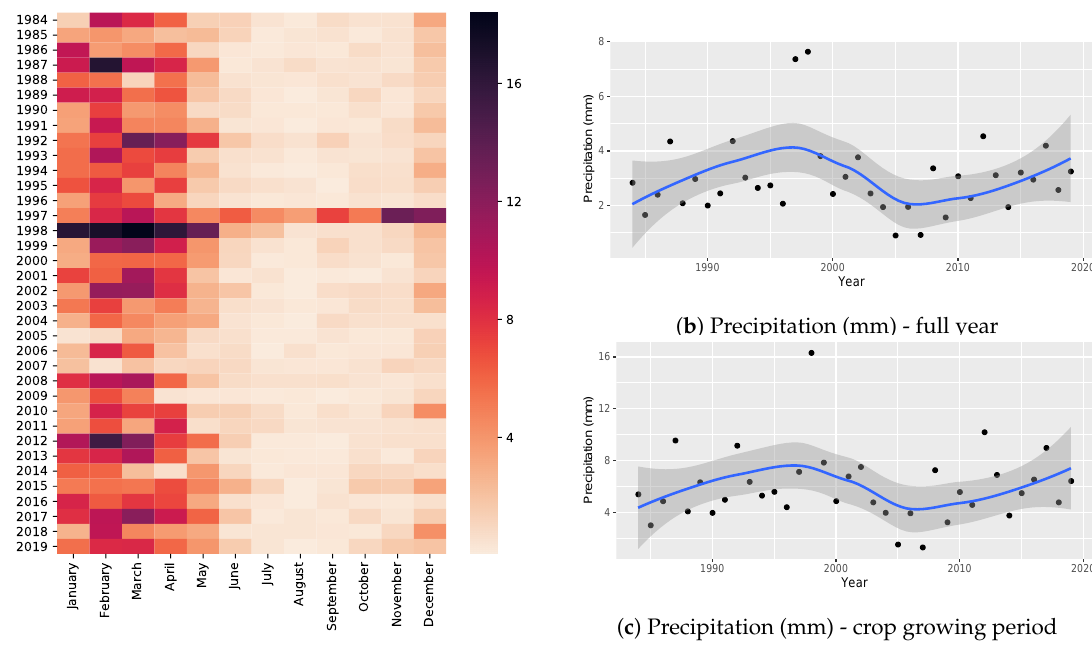
Figure A14. Time series of daily average precipitation (mm) in Manabi from 1984 to 2019. ( a ) Heat-map of daily precipitation (mm) per each month and year. The color scale represents the precipitation in mm. ( b ) Daily precipitation averaged during the full year. ( c ) Daily precipitation averaged during the maize crop growing period in Ecuador (January–May). Each dot represents one record, the blue line shows the smoothed time series and the shaded area represents the 95% confidence interval.